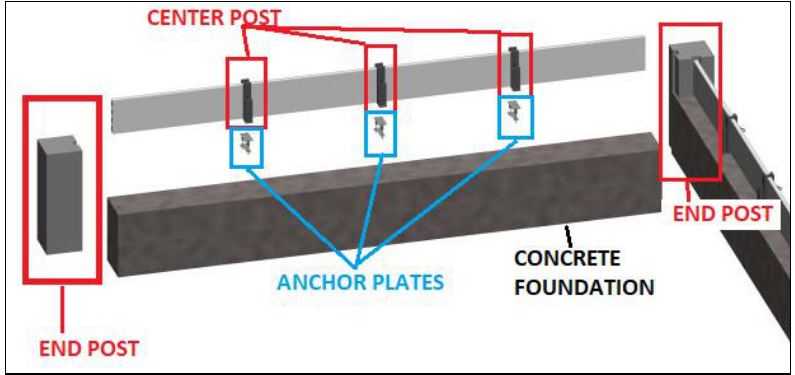
Figure 5. Building information modeling (BIM) model of the removable floodwall components.